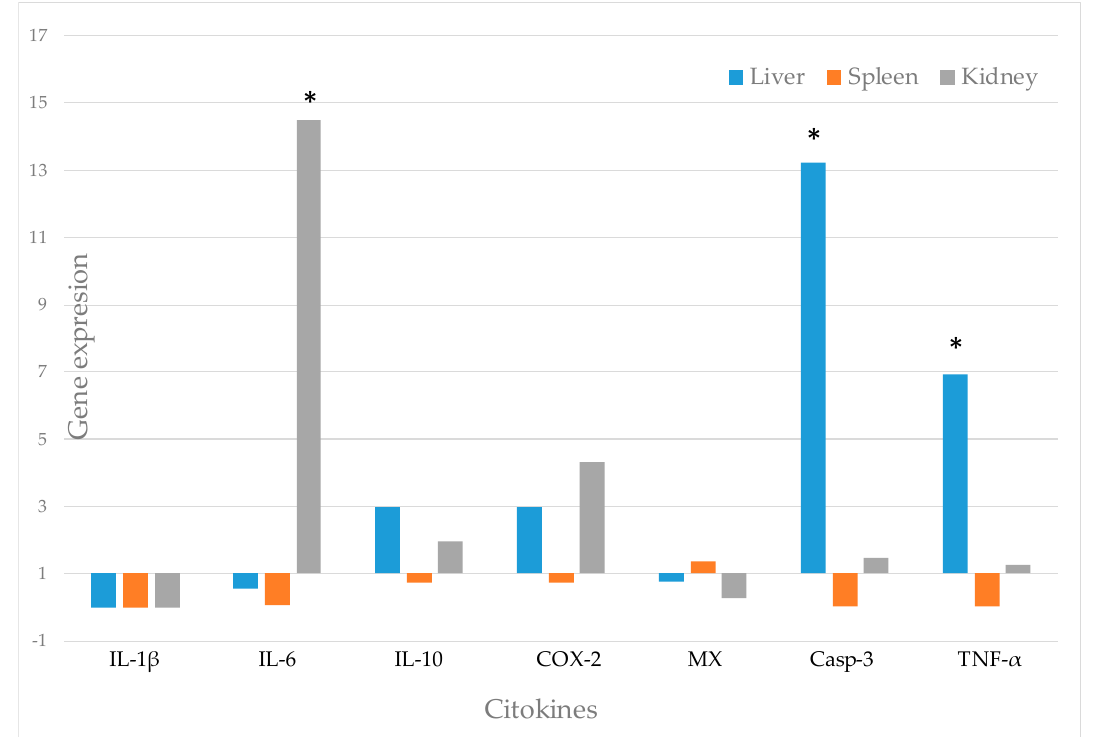
Figure 1. Gene expression of IL-1 β , Il-6, IL-10, COX-2, Mx, Casp-3 and TNF- α in seabass after Alc. faecalis subsp. faecalis -1 administration in experimental diet for 30 days. Asterisks denote significantly different ( p < 0.05).